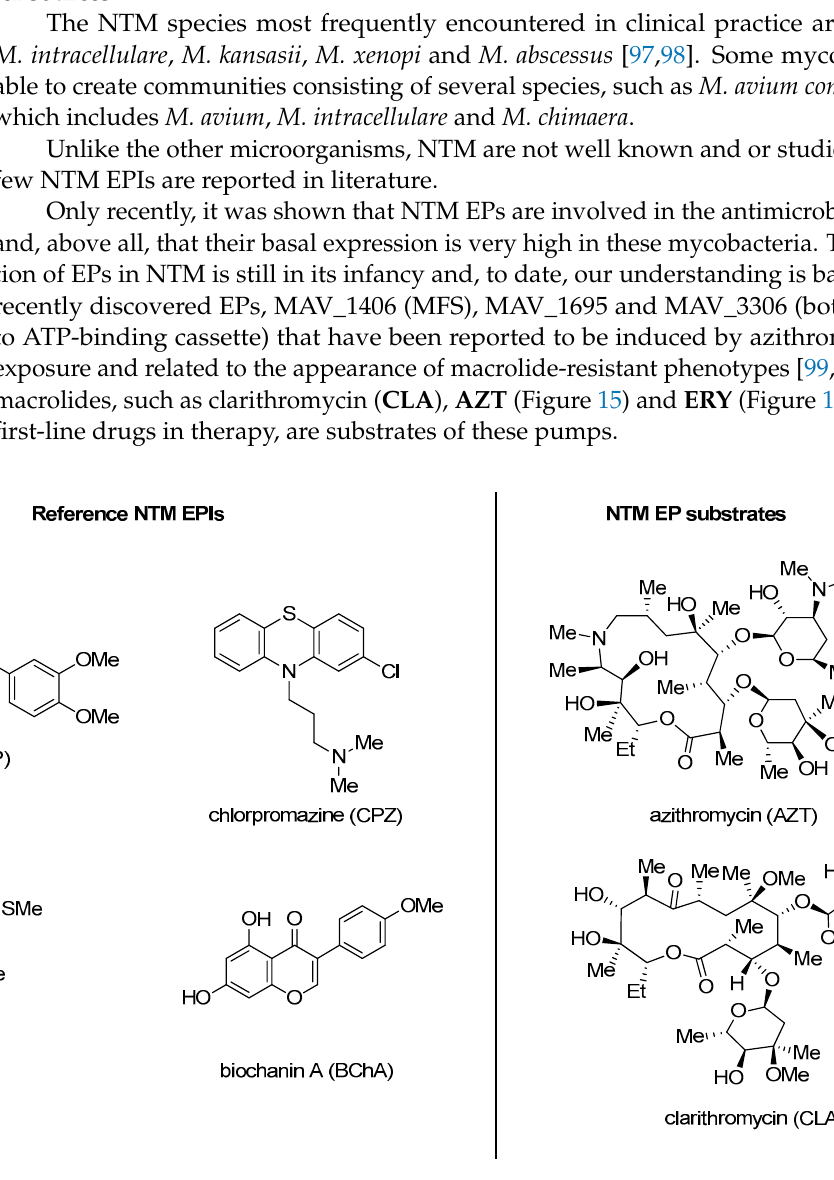
Figure 15. Reference NTM EPIs verapamil ( VP ), chlorpromazine ( CPZ ), thioridazine ( TDZ ) and biochanin A ( BChA ) and NTM EP substrates azithromycin ( AZT ) and clarithromycin ( CLA ).